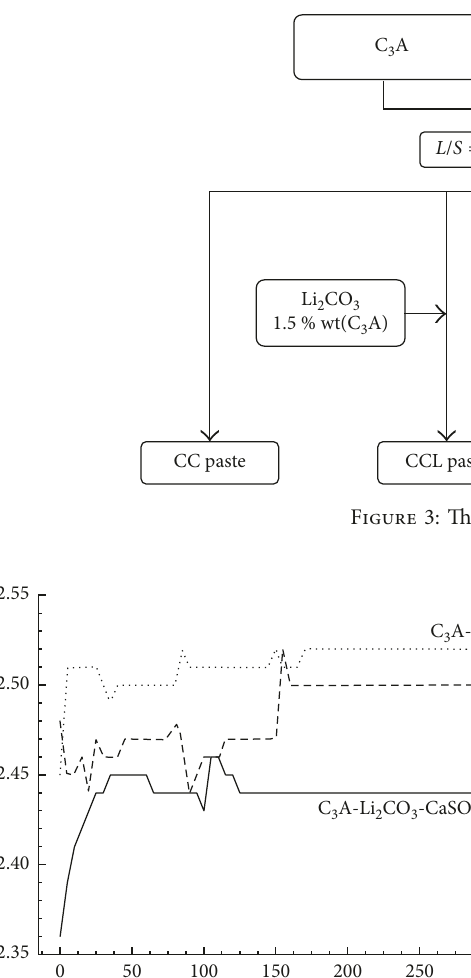
Figure 4: pH value of the pastes.